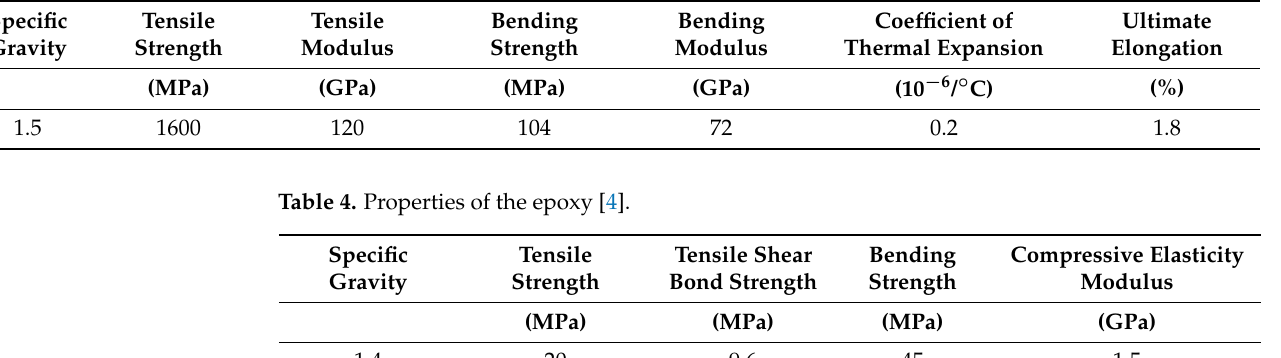
Table 3. Properties of CFRP [4].